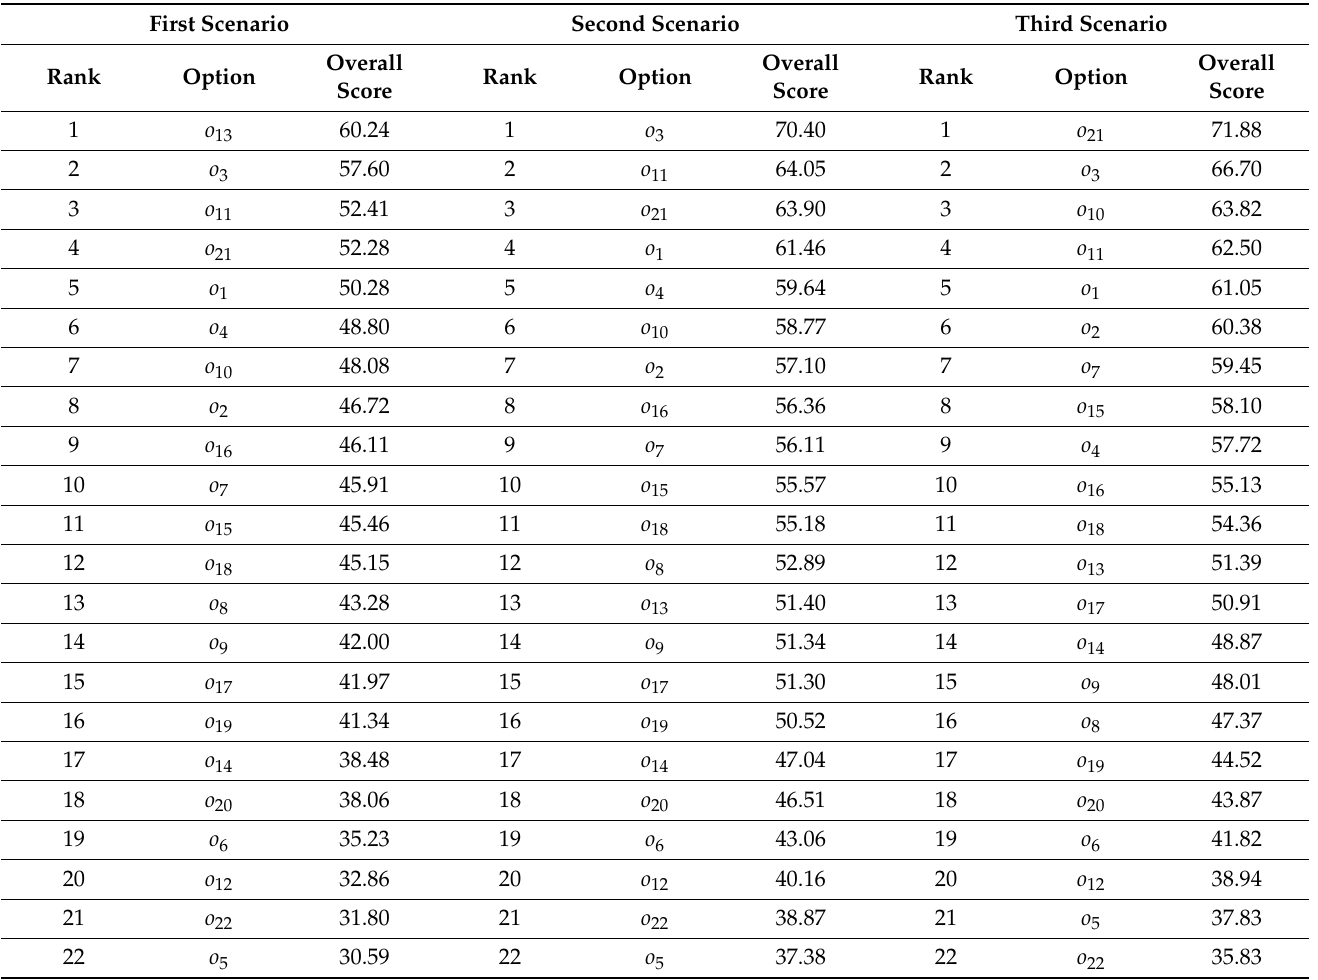
Table 5. The comparison of scenarios’ final ranks and overall